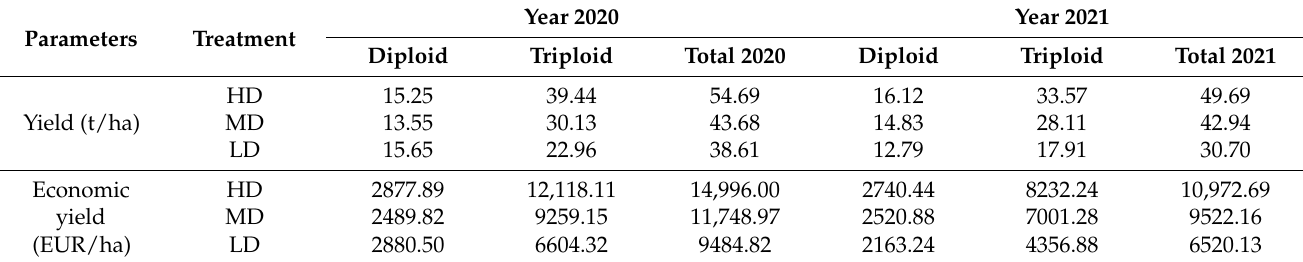
Table 6. Commercial yield (t/ha) and economic return (EUR/ha) of watermelon orchard adding production of both cultivars. Years 2020 and 2021 for the three treatments (release density: HD, MD, and